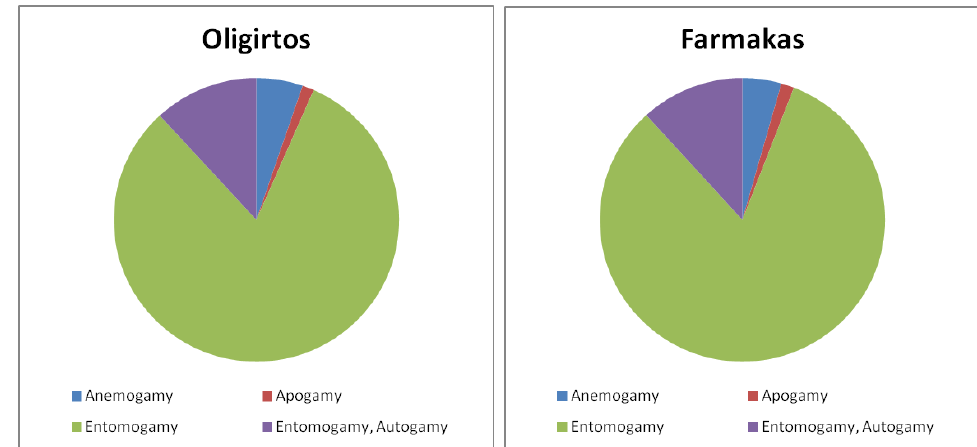
Figure 3. Pollination mode of the Greek endemic taxa found in the flora of Mts. Oligirtos and Farmakas. (Kruskal – Wallis one-way ANOVA: H = 0.19, df = 1, p = 0.663).